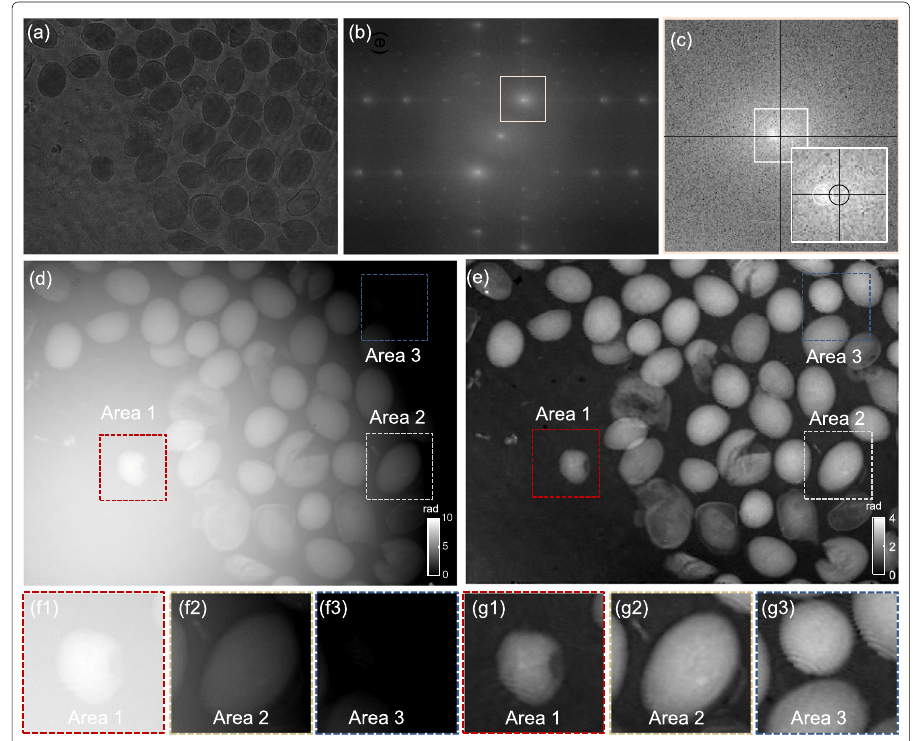
Fig. 7 Comparison of reconstructed phase without and with correcting the off-axis tilt aberration and quadratic wavefront aberration. (a) Recorded hologram. (b) Spectrum of the hologram. (c) Extracted +1-order spectrum. (d) Reconstructed phase without correcting the off-axis tilt aberration and quadratic wavefront aberration. (e) Reconstructed phase with correcting the off-axis tilt aberration and quadratic wavefront aberration. (f1)-(f3) The selected subregions in (d). (g1)-(g3) The selected subregions in (e)